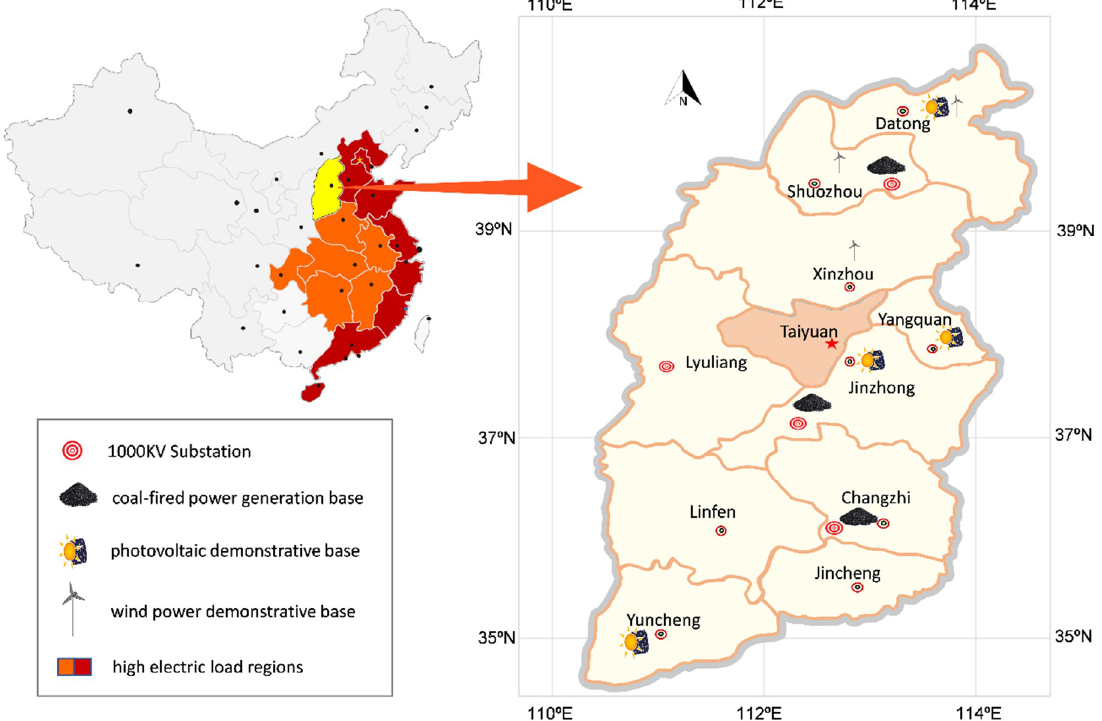
Figure 1. The study area.